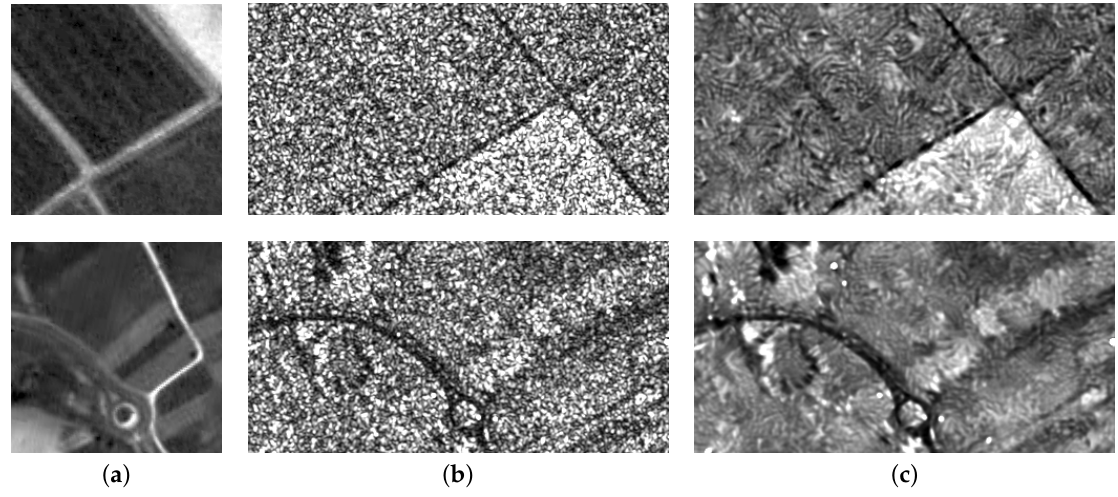
Figure 3. Visual comparison between optical ( a ), SAR ( b ) and despeckled SAR patches ( c